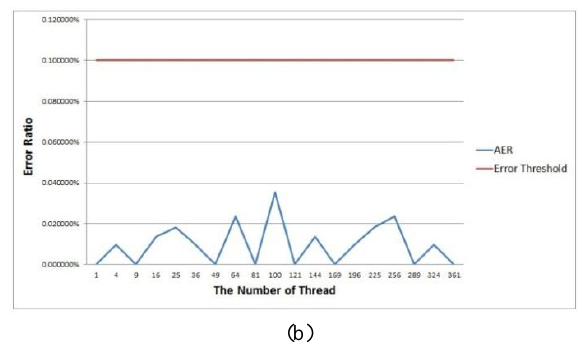
Figure 8. The efficiency of multi-thread parallel method and the variation of AER